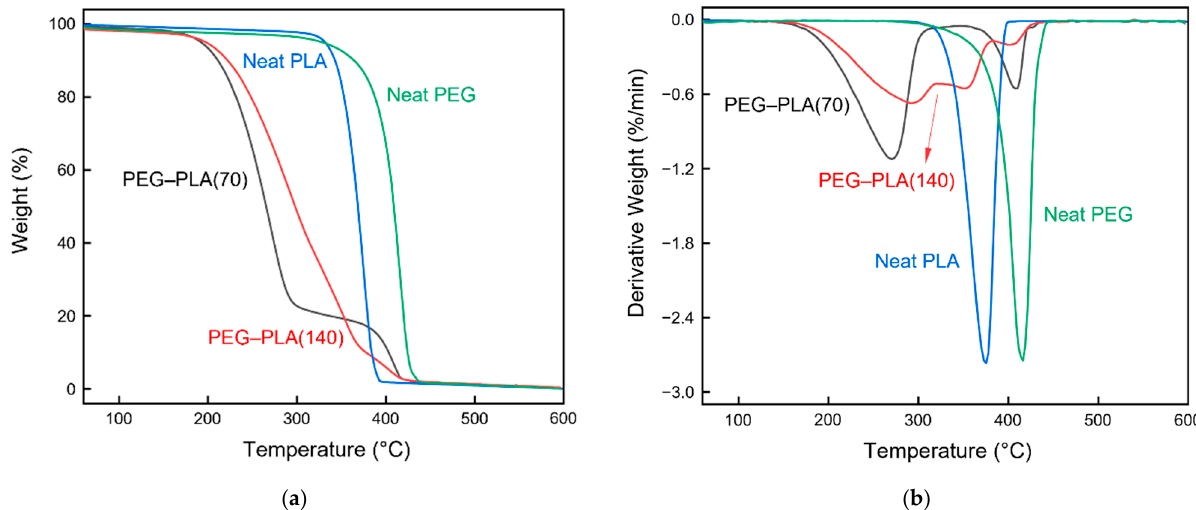
Figure 11. ( a ) TGA and ( b ) DTG profiles of the hydrophobic materials.